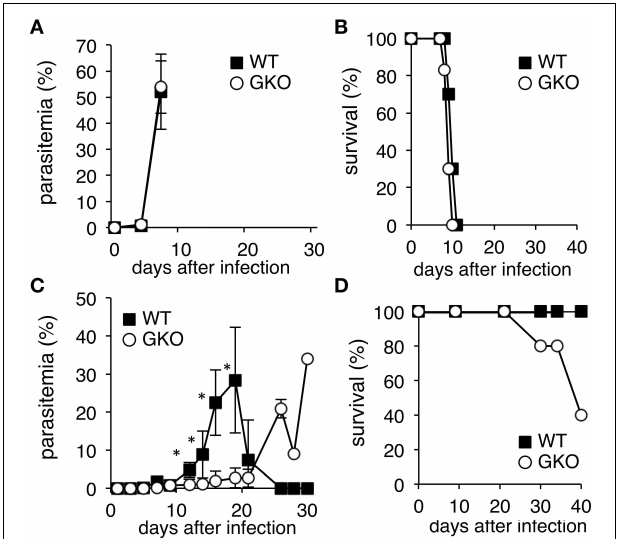
FIGURE 1 | Course of infection of P. yoelii in WT and GKO mice. Parasitemias (A,C) , and survival rates (B,D) were monitored in WT (closed squares) and GKO mice (open circles) infected with either PyL (A,B) or PyNL (C,D) . Parasitemias were calculated based on microscopic observations of Giemsa-stained thin blood films. WT and GKO groups comprised five mice each. Values of parasitemia represent mean ± standard deviation. Asterisks denote statistical significance at p < 0 . 05 using Student’s t -test. Similar results were obtained from three repeated